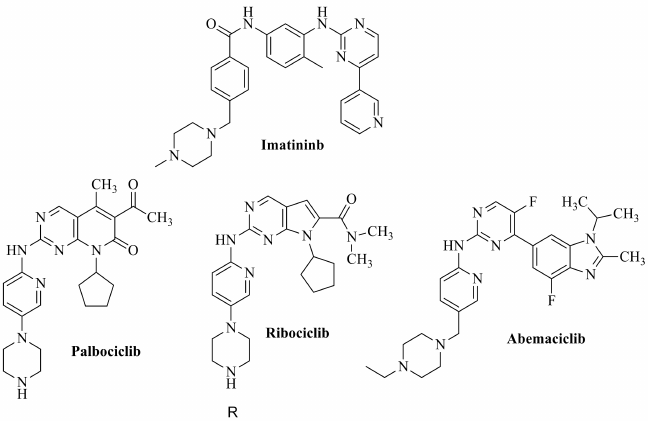
Figure 1. 2-Aminopyrimidine derivatives as anticancer drugs.